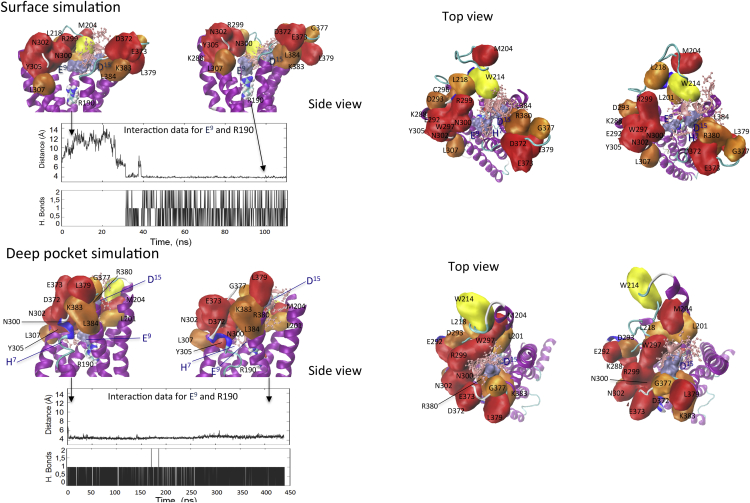
MD Simulations of Peptide Interaction with GLP-1 Receptor Models, Related to Figures 1 and 2In the surface simulation (A–D), the N-terminal GLP-1 peptide fragment was placed such that D15 of the peptide was within 10 Å of R380 of the receptor, but no specific tethers were used. For this simulation, an open model of the receptor was used based on homology modeling using the CRF1 receptor crystal structure as initial template. The simulation was run for 220 ns. Interaction data for peptide residue E9 and receptor residue R190 are shown in the inset panels. The upper inset displays the distance between Cδ (carbon delta) of E9 of GLP1 and Cζ (carbon zeta) of R190 of GLP-1R during the first 110 ns of the MD simulation. The E9-R190 hydrogen-bonded salt-bridge engaged at ∼t = 30 ns and then remained stable during the remainder of the 220 ns MD simulation. The lower panel of the inset displays hydrogen bonds between E9 of GLP1 and R190 of GLP-1R during the first 110 ns of MD simulation. The donor–acceptor distance cutoff was 3.0 Å, and the angle cutoff was 20°. The E9-R190 hydrogen-bonded salt-bridge remained stable during the remainder of the 220 ns MD simulation. Side views from the simulation are illustrated in (A) early time point, and (B) after ∼100 ns where a stable interaction between the ligand and peptide had been formed. Panels (C) and (D) illustrate top views at each of the time points, respectively.In the deep pocket simulation (E–H), MD was performed for a total of 500 ns, commencing with the final model of the full-length peptide bound receptor. The interaction between E9 of the peptide and R190 of the receptor remained stable for the duration of the simulation. Inset panels display distances between Cδ (carbon delta) of E9 of GLP1 and Cζ (carbon zeta) of R190 of GLP-1R (upper inset) and hydrogen bonds between the two residues where donor–acceptor distance cutoff was 3.0 Å, and the angle cutoff was 20°. Panels (E) and (F) illustrate side views of early and late time points during the simulation. Panels (G) and (H) illustrate the equivalent top views, respectively.The GLP-1 peptide fragment is displayed in pink (cpk) except for E9 and D15 of the peptide (surface display, ice blue). The receptor is displayed in cartoon form, with the backbone colored by secondary structure. GLP-R residue 190 is displayed as VDW representation (colored by atom). GLP-1R residues that when mutated to alanine decreased GLP-1 peptide affinity are illustrated by quick surface, colored according to the fold-change in affinity (yellow, 3- to 5-fold; light orange, 5- to 10-fold; dark orange, 10- to 30-fold; red, >30-fold).See Movies S1 and S2.